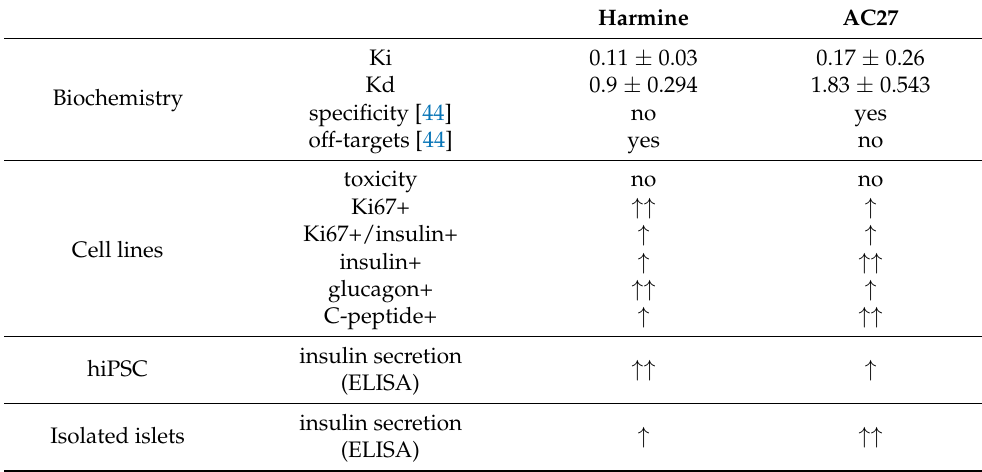
Table 2. The comparison of selected properties of harmine and AC27. Abbrev. In order: ↑ / ↑↑ = moderate/most